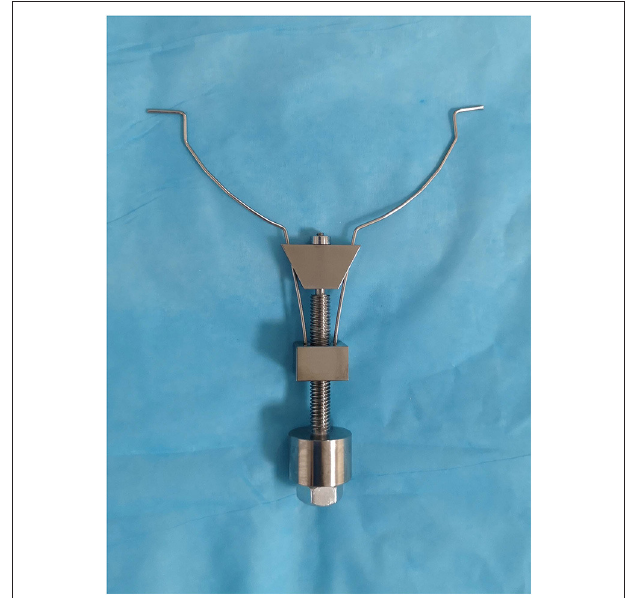
FIGURE 1 | The vascular prop device